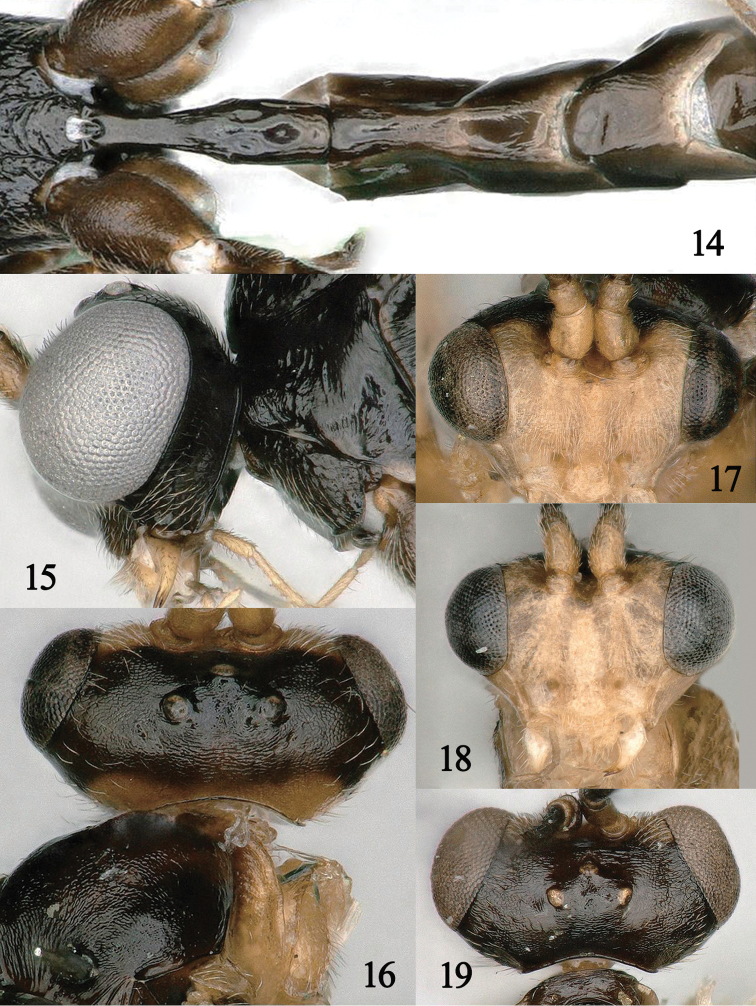
14, 15Myiocephalus
niger Fischer, ♀ 14 first metasomal tergites, dorsal aspect 15 head, lateral aspect 16, 17Myiocephalus
boops (Wesmael), ♂ 16 head, dorsal aspect 17 head, anterior aspect 18Myiocephalus
laticeps (Provancher), ♂, head, anterior aspect 19Myiocephalus
zwakhalsi van Achterberg, ♀, head, dorsal aspect (figures 14–19 from Tan et al. 2019).